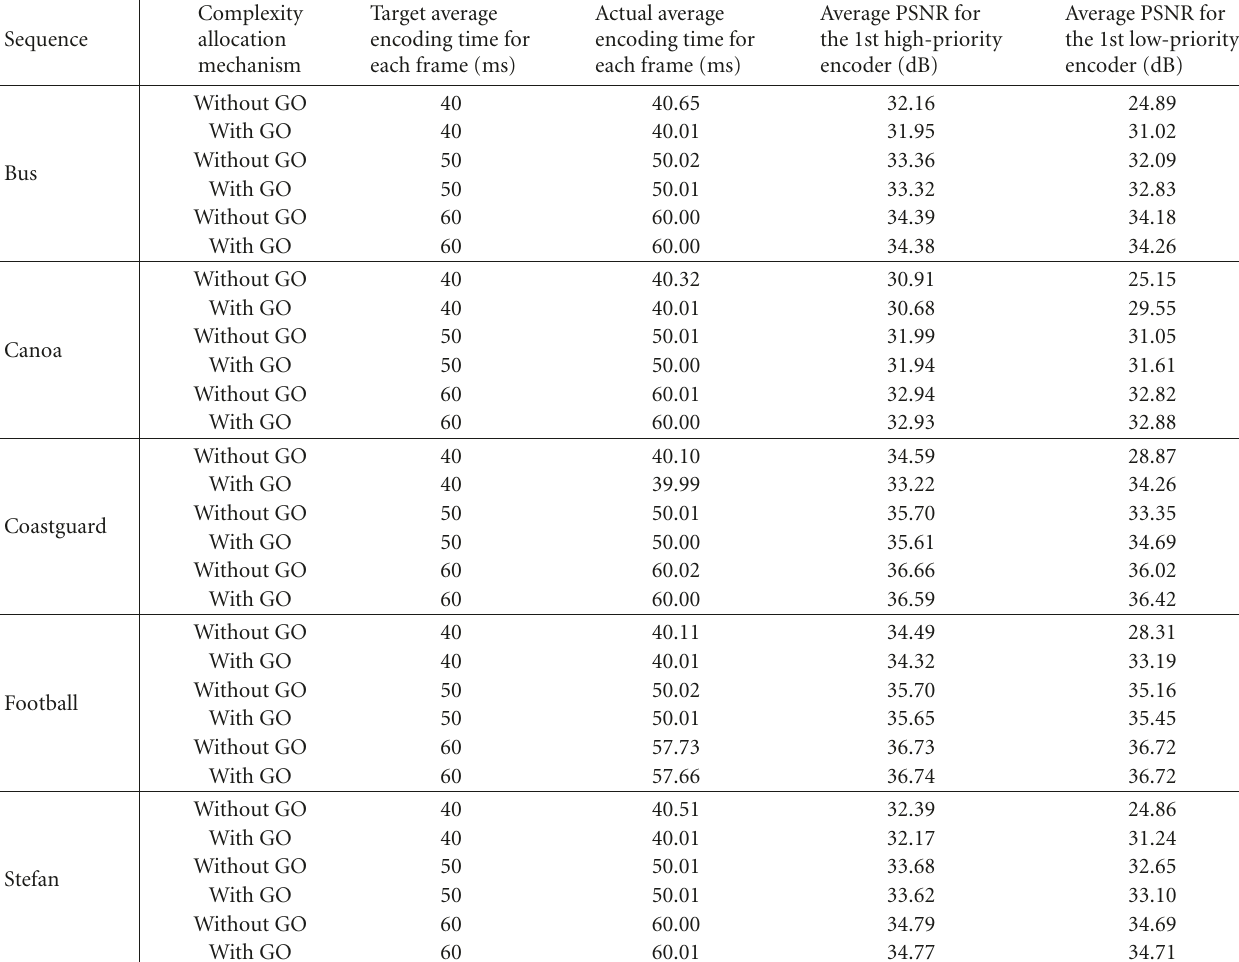
Table 4: Results of resource allocation with global optimization (GO) versus without GO for two high-priority and two low-priority chan-